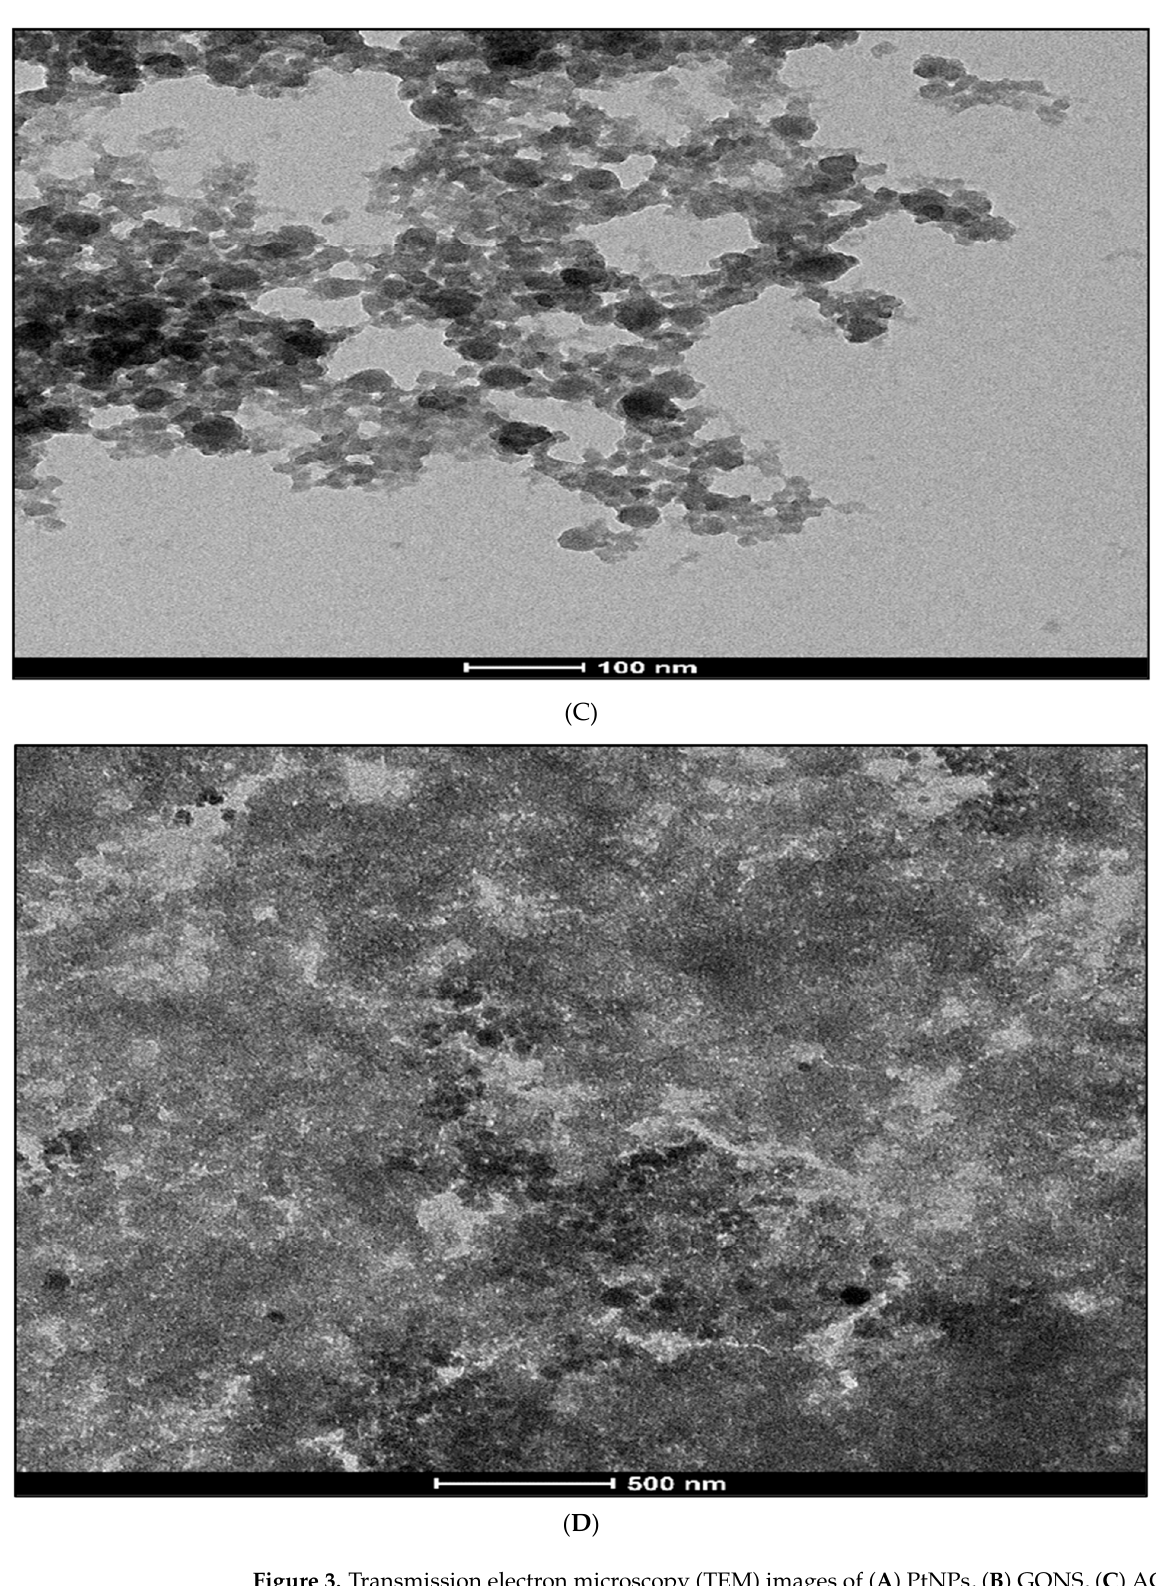
Figure 3. Transmission electron microscopy (TEM) images of ( A ) PtNPs, ( B ) GONS, ( C ) AChENPs and ( D ) ChONPs. (AChENPs = Acetylcholine esterase nanoparticles; ChONPs = Choline oxide nanoparticles; GONS = Graphene oxide nanosheets; PtNPs = Platinum nanoparticles).